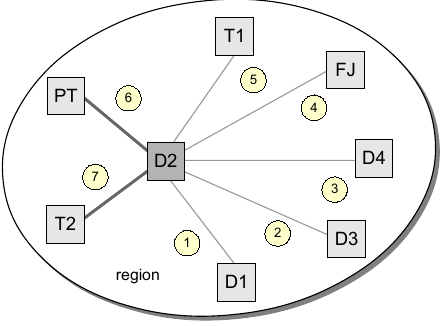
Figure 10. The network layout and bandwidth shaping imposed on ping services